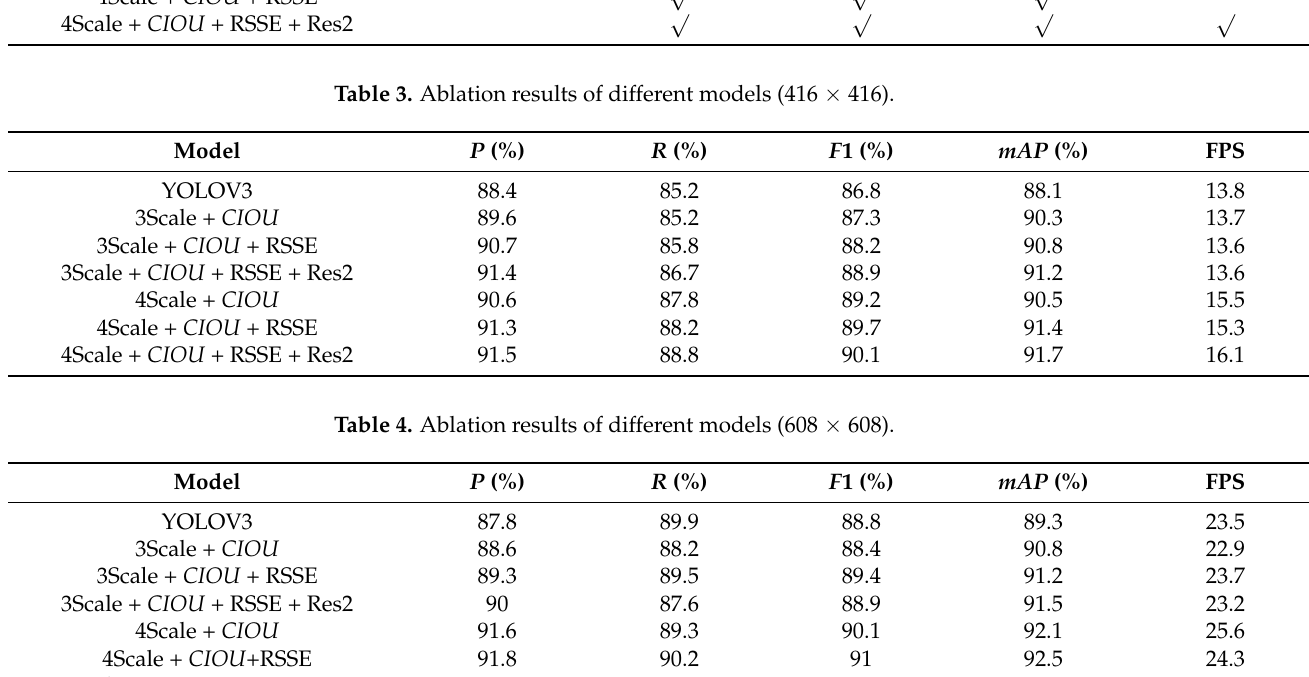
Table 2. Different improvement schemes. “